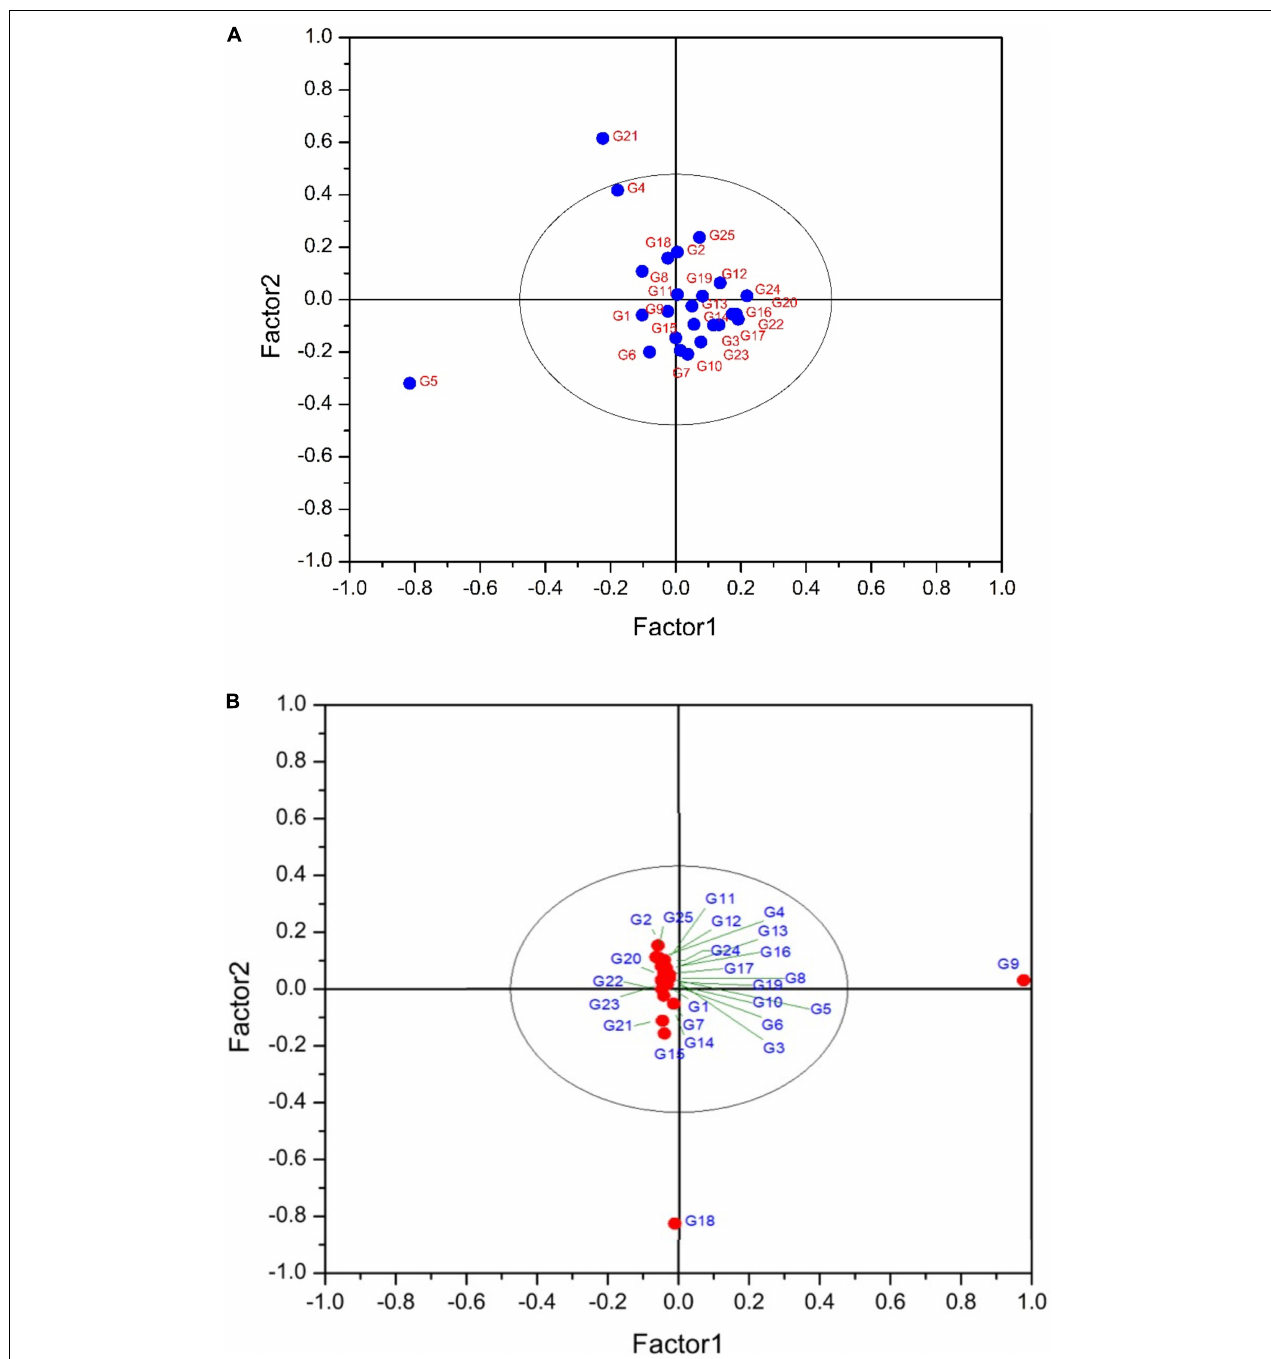
FIGURE 7 | (A) PLS-DA plot showing the distribution of scanned peel samples. The variance explained by the factor1 and 2 are 77.40 and 15.44%, respectively. G1 to G25 refer to the cultivars codes as given in the Table 1 . (B) PLS-DA plot showing the distribution of scanned pulp samples. The variance explained by the factor1 and 2 are 80 and 10.78%, respectively. G1 to G25 refer to the cultivars codes as given in the Table 1